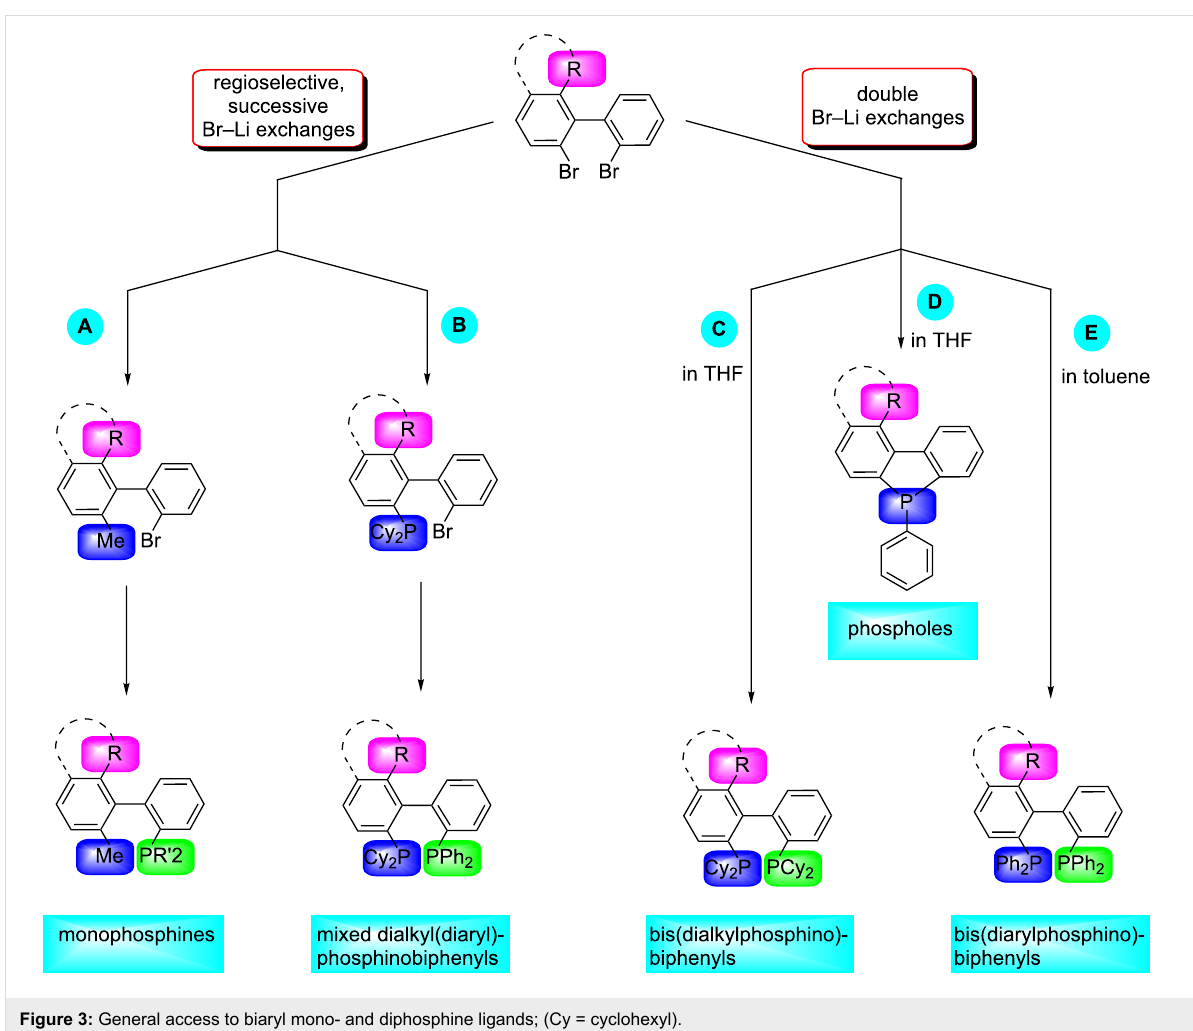
Figure 3: General access to biaryl mono- and diphosphine ligands; (Cy = cyclohexyl).